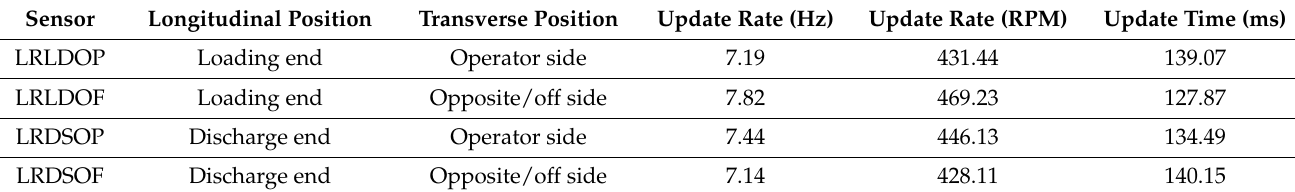
Table 3. Effective update rates of onboard sensors (calculated by the data collection microcontrollers).